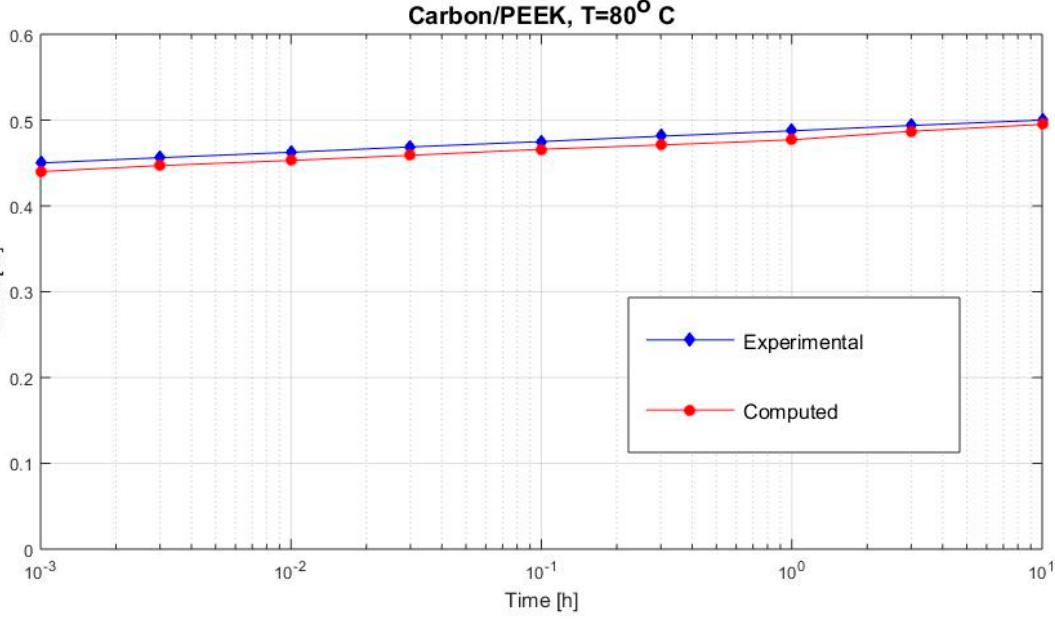
Figure 6. Creep strain ε 22 (carbon / PEEK subjected to σ 22 = 36 MPa at 80 ◦ C).